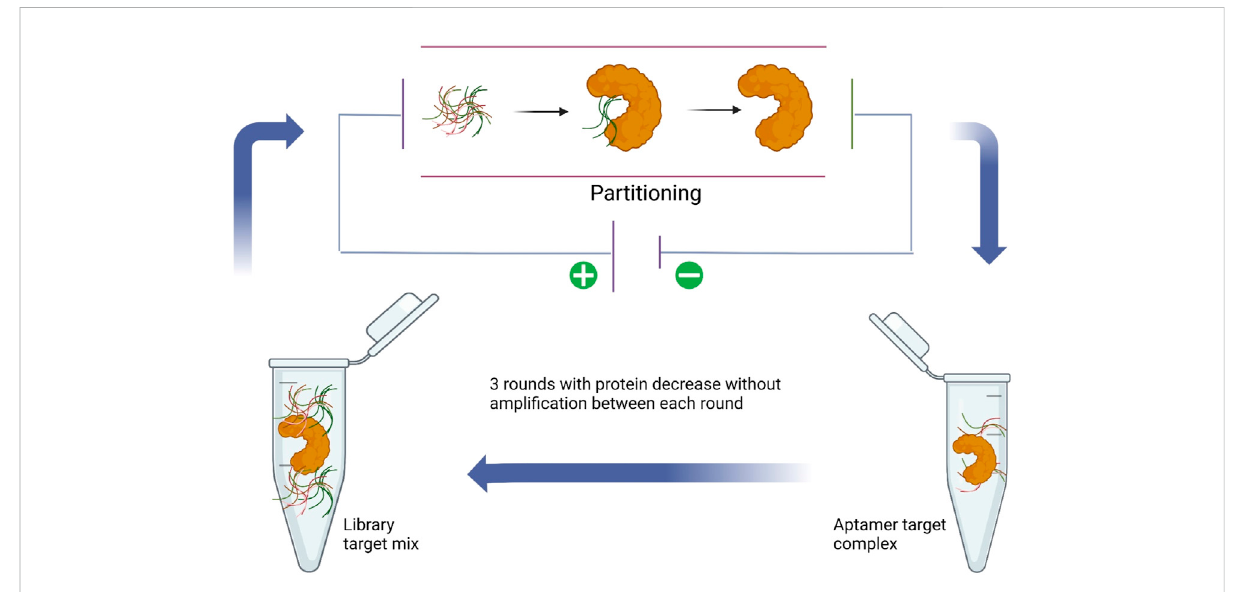
FIGURE 3 NECEEM-based non-SELEX method (Lisi et al.,